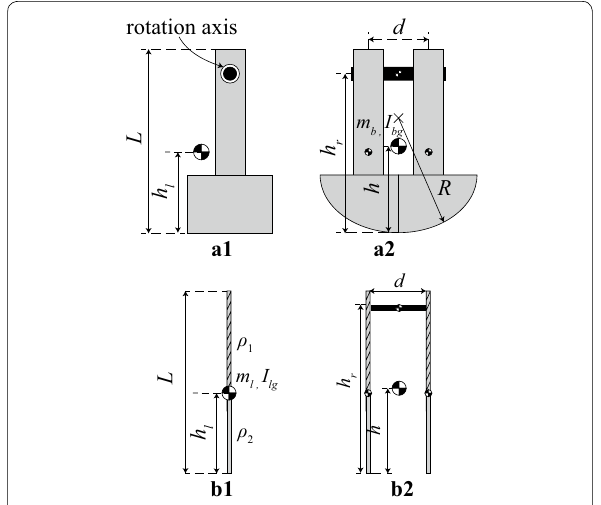
Fig. 4 A schematic of a thermal walker. a1 Side view. a2 Back view. b1 A model for calculating I lg . b2 A model for calculating I bg